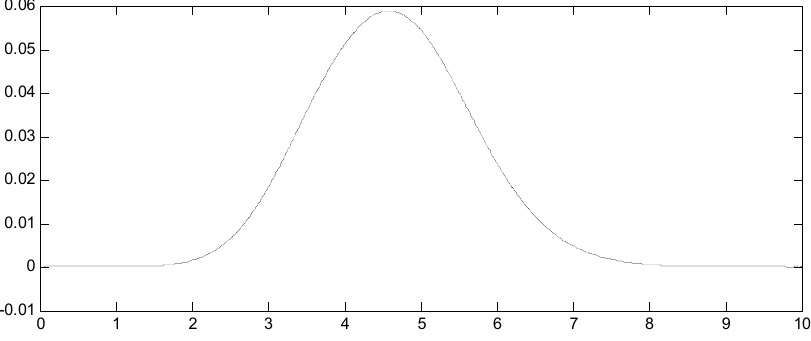
Figure 15. Case 1: Evolution of the control law u 1 .